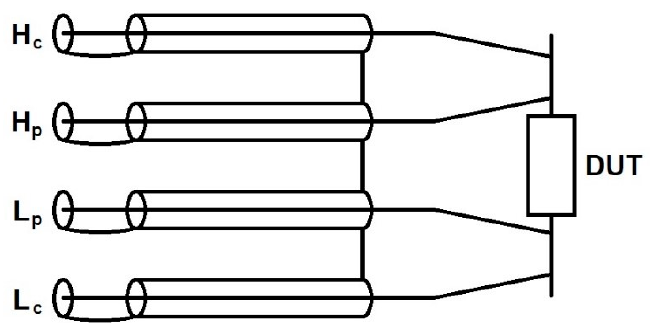
Figure 9. Connection configuration when using an LCR meter as a capacitance bridge to test the capacitance of a device under test (DUT).